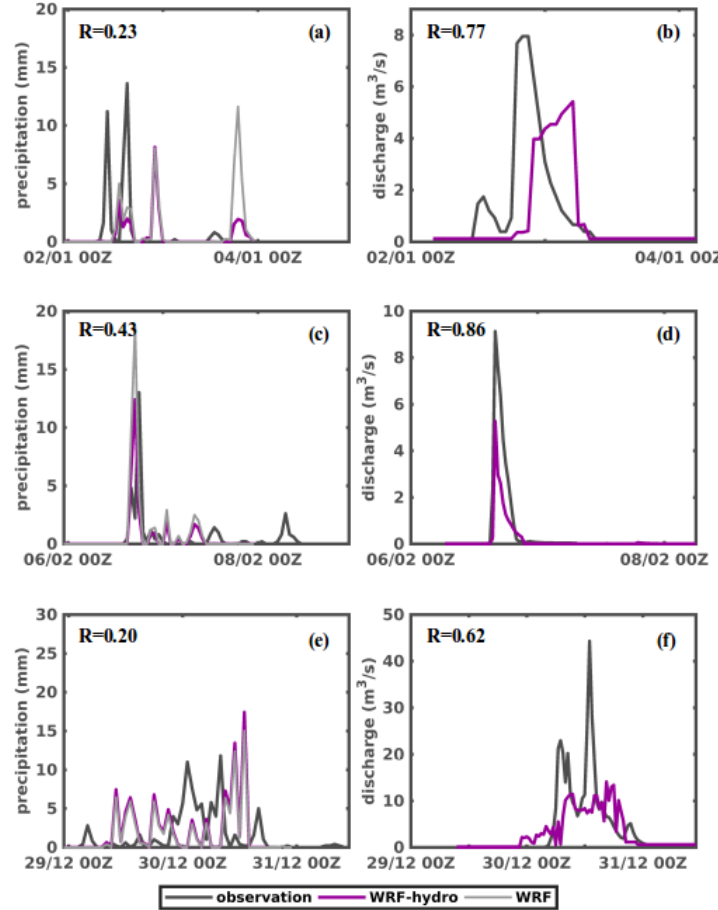
Figure 8. The temporal distribution of the observed and simulated (a) precipitation and (b) discharge for event 1 and the same variables for event 3 (c, d) and event 4R (e, f)